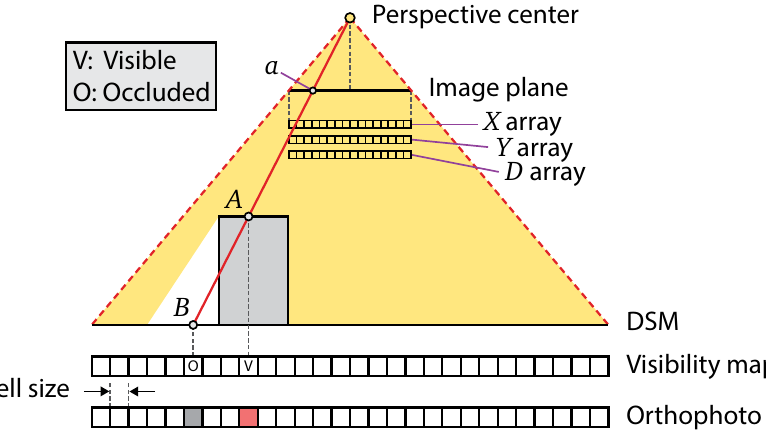
Figure 3. Principle of occlusion detection using the Z-buffer